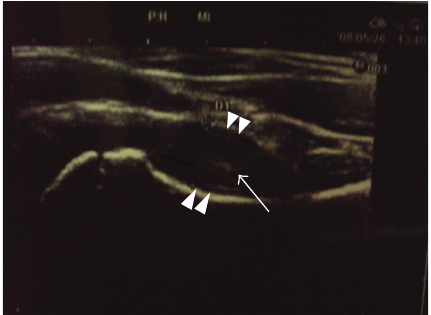
Figure 4: Ultrasonic joint space (distance from the anterior cortex of the femoral neck to the front of the capsule [the width of the joint space]) 2 months after the initial visit. It was 11.6mm for the left hip (arrowheads). The intracapsular space showed echoic findings